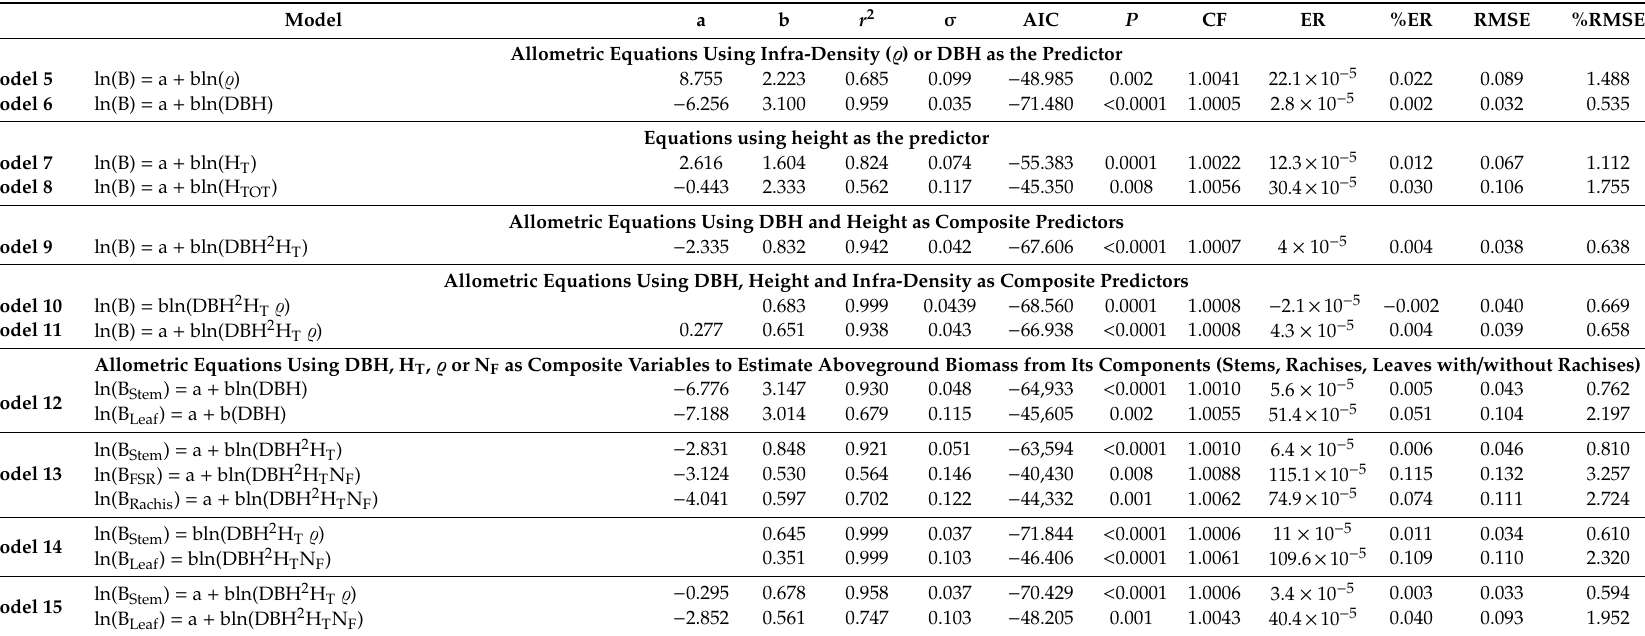
Table 5. Local allometric biomass models that were developed in this study. B is the total dry aboveground oil palm biomass. B Stem , B Leaf , B FSR and B Rachis are respectively stem, leaf (including petioles, rachis and leaflets), rachis-free leaf and rachis biomasses. P is the p -value of the model. Residual standard error ( σ , in kg), the correction factor (CF), the ER and the RMSE are shown for each